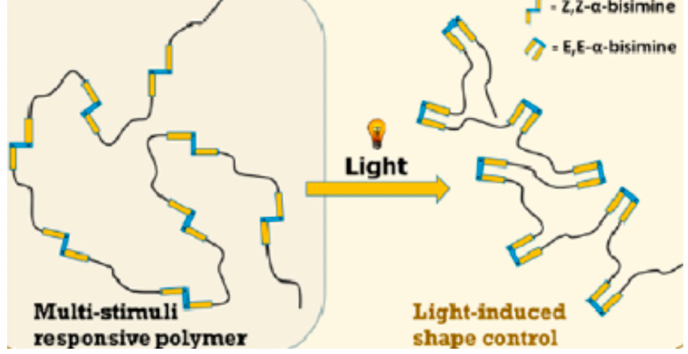
Schematic illustration of the controlled switching of size / shape with light via photoisomerization of an ADMET-polymer containing main-chain N-alkyl α -bisimine units. Reprinted from [39] with